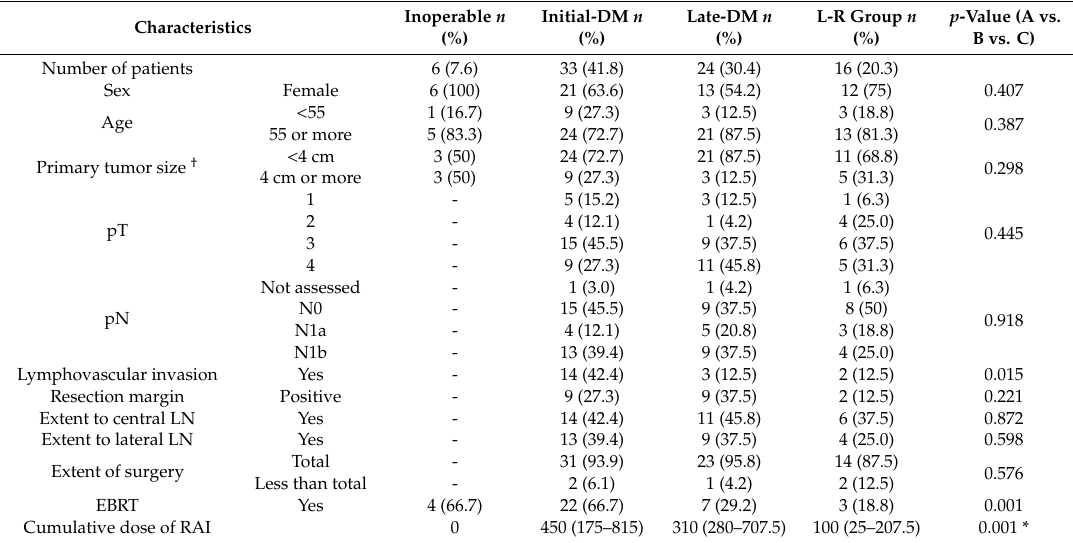
Table 2. Clinicopathologic characteristics of 79 enrolled well-di ff erentiated thyroid cancer patients.